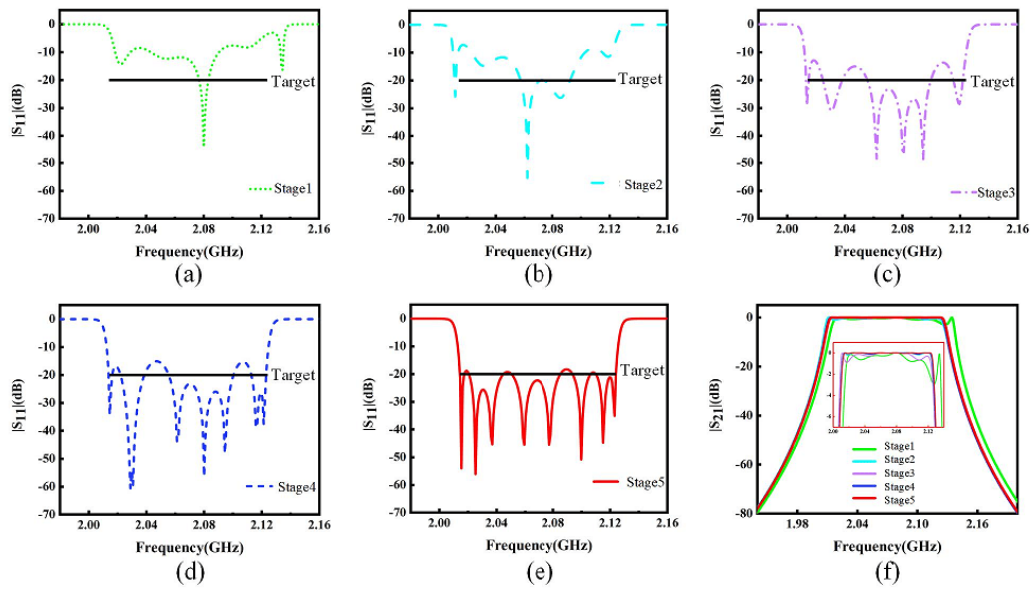
Figure 14. Eighth − order cavity filter HFSS verification of the optimized response in PSO iterations. ( a – e ) Reflection coefficient S 11 . ( f ) Transmission coefficient S 21 .